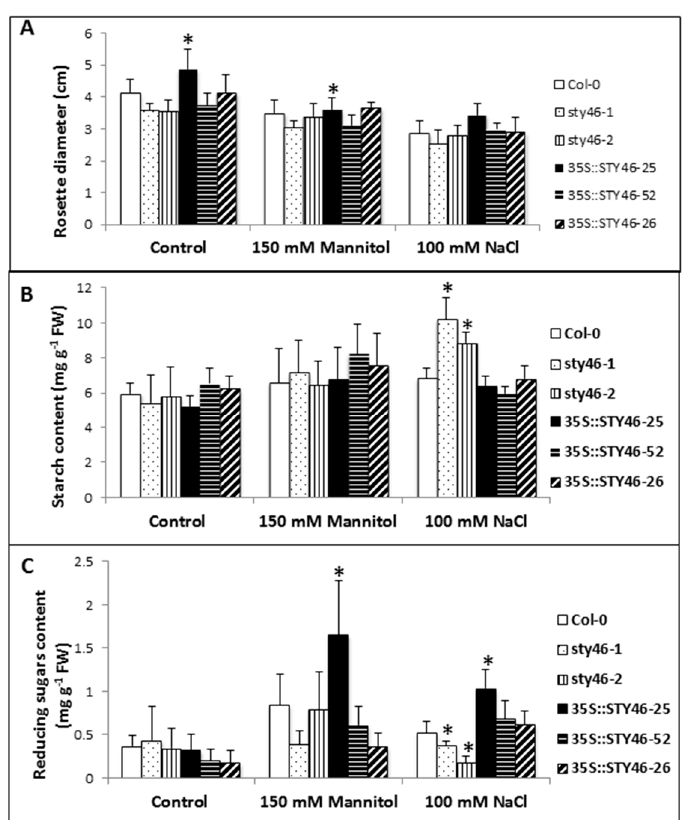
Figure 6. Growth and carbohydrate content of STY46 transgenic lines grown under control conditions and abiotic stress. Rosette diameter ( A ), starch content ( B ), and reducing sugar content ( C ) of two-week-old plants were exposed to 150 mM mannitol and 100 mM NaCl for 10 days. Samples for carbohydrate measurements were harvested at the end of the day. The asterisks indicate statistically significant differences between transgenic lines and the wild type control ( n = 6, p < 0.05).